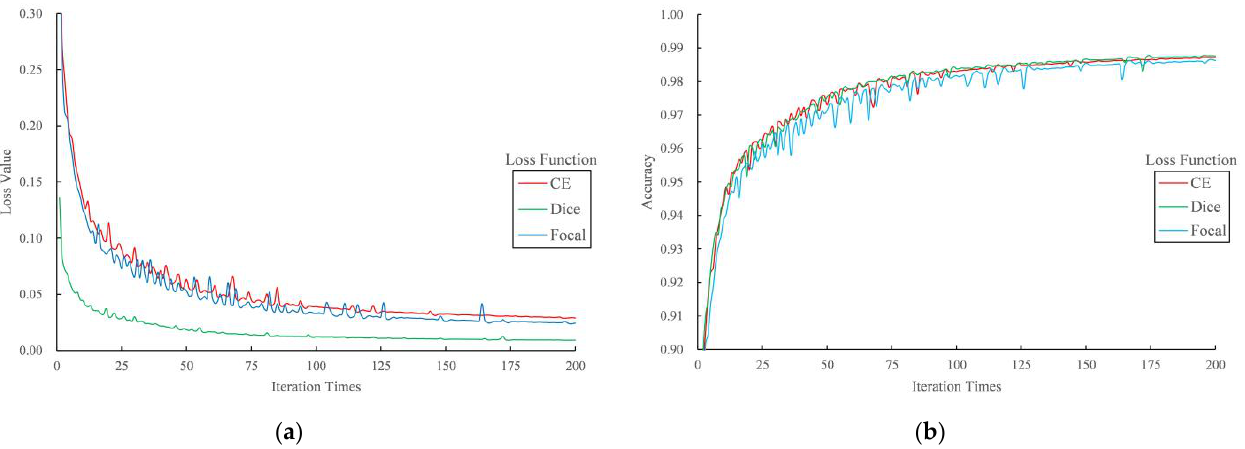
Figure 7. The change curve of training loss value with the iterations times ( a ) and the change curve of training accuracy with the iterations times ( b ) under different loss functions.